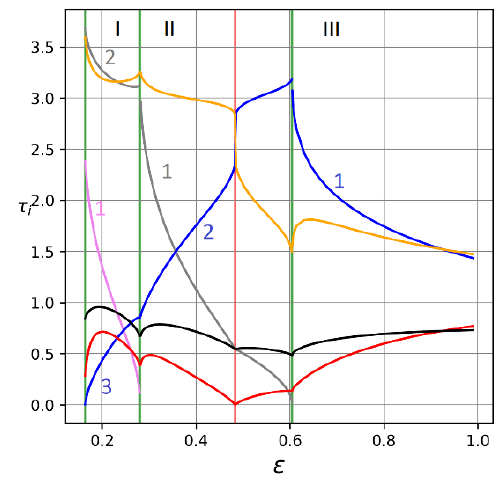
Figure 6. Dependencies τ i ( ε ) .